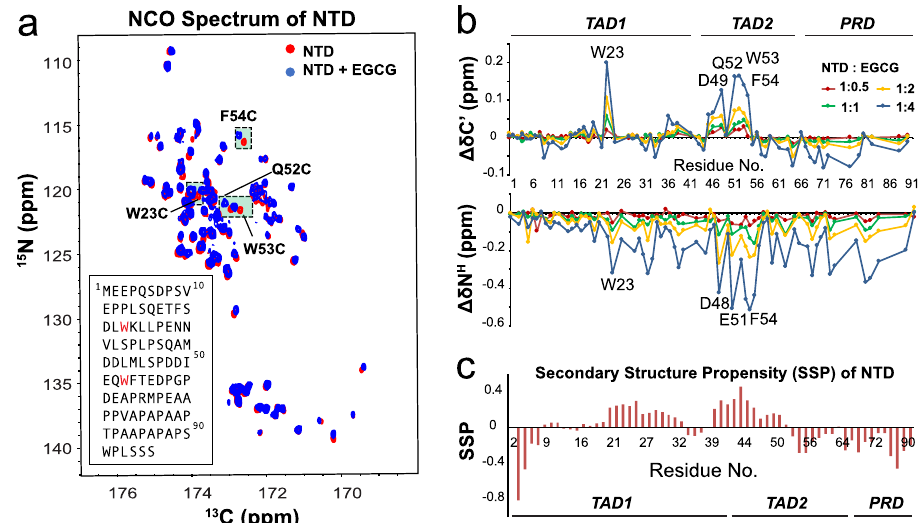
Fig. 2 15 N – 13 C NCO titration of p53 NTD with EGCG. a Overlay of 15 N – 13 C NCO spectra of 0.3 mM p53 NTD, apo (red) and in the presence 1.2 mM EGCG (blue). b CSPs of carbonyl carbon (C ’ ) and amide nitrogen (N H ) of p53 NTD (0.3 mM) titrated with EGCG, at NTD:EGCG ratios of 1:0.5 (red), 1:1 (green), 1:2 (yellow), and 1:4 (blue). Residues with largest CSPs were marked by residue type and number. Source data are provided as a Source Data fi le. c Secondary structure propensity (SSP) of p53 NTD. An SSP score of 1 or − 1 re fl ects fully formed α -helix or β -sheet structure, while a score of ~0.5 or ~ − 0.5 indicates signi fi cant propensity for α -helix or β -sheet, respectively. Source data are provided as a Source Data fi le.